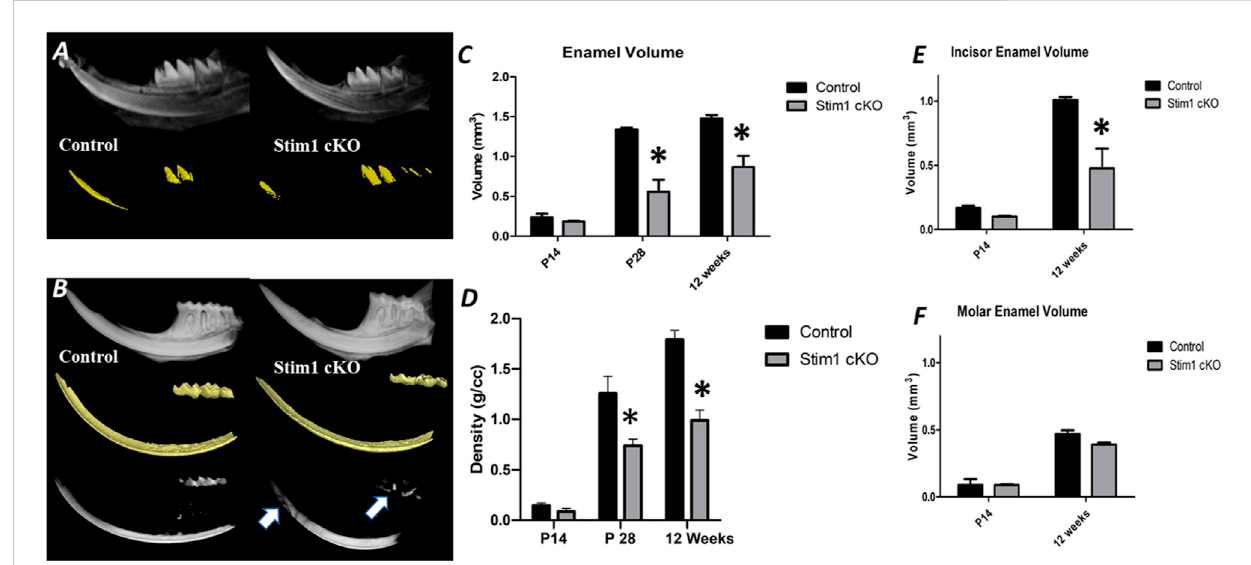
FIGURE 4 Micro-computed tomography ( μ CT) analysis of enamel. (A,B) A 3D μ CT of the control (left column) and Stim1 cKO (right column) hemimandibles collected from mice at postnatal day14 (P14) (A) and 12 weeks (B) . The Stim1 cKO mice showed loss of enamel volume (color-coded gold) and thickness in Stim1 relative to their control littermates in incisors and molars at 12 weeks while no signi fi cant differences were noticed at P14. For 12 weeks samples thethresholdvalueforimagingwasraiseduntilenamelwastheonlymineraldisplayedinthecontrolgroup.theenameloftheteethworkingsurfaces (i.e., incisor tips and molar cusps) does not reach the threshold level in the Stim1 cKO mice (B, arrows). Quantitative analysis for enamel volume (C) and enamelmineralization (D) showedthatStim1cKOenameldisplayedreducedvolumeandmineraldensitiesthatincreaseswithage.Thethresholdvolume ofmineralizedenamel wasreduced inincisors (E) more signi fi cantly comparedto molars (F) inboth young (P14) and old(12 weeks) mice (mean ±SEM of n = 3 mice per group; * p <